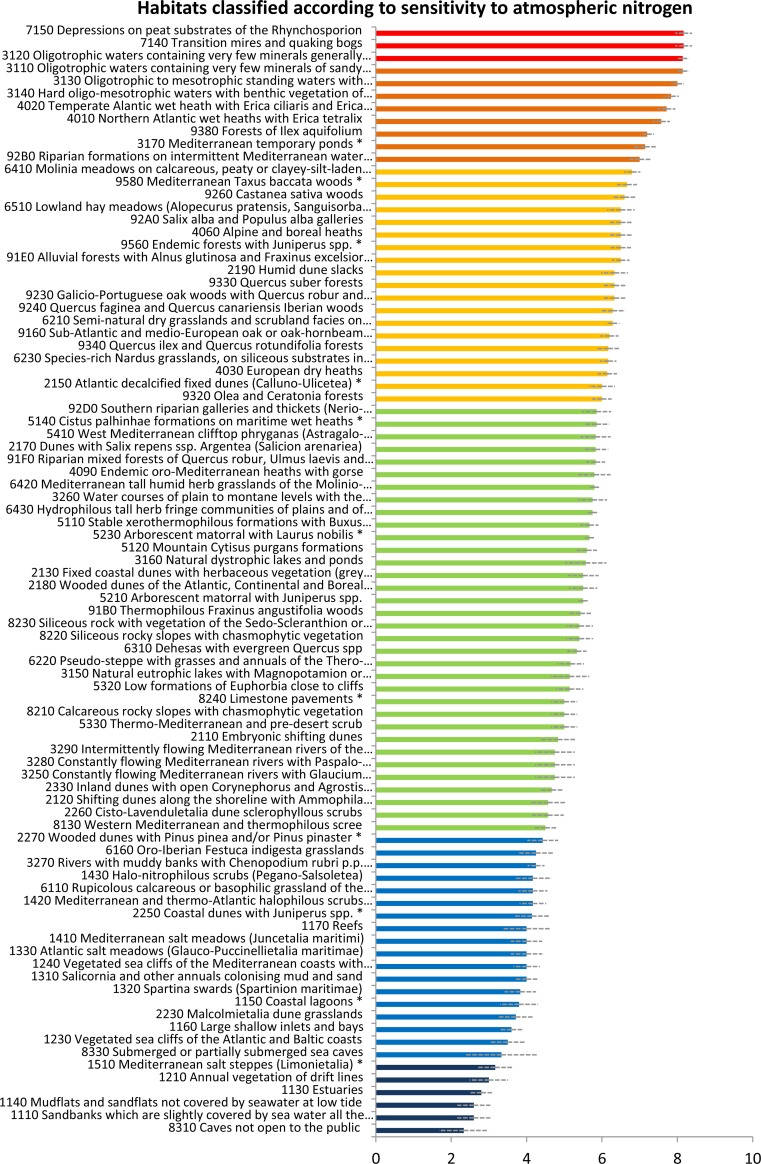
Ranking of the habitats (Habitats Directive) occurring in mainland Portugal according to their sensitivity to atmospheric Nitrogen pollution (higher values in red indicate higher sensitivity).The bars represent the average relative standard deviation (the same as in Table 1). See full habitat names in Table 1.